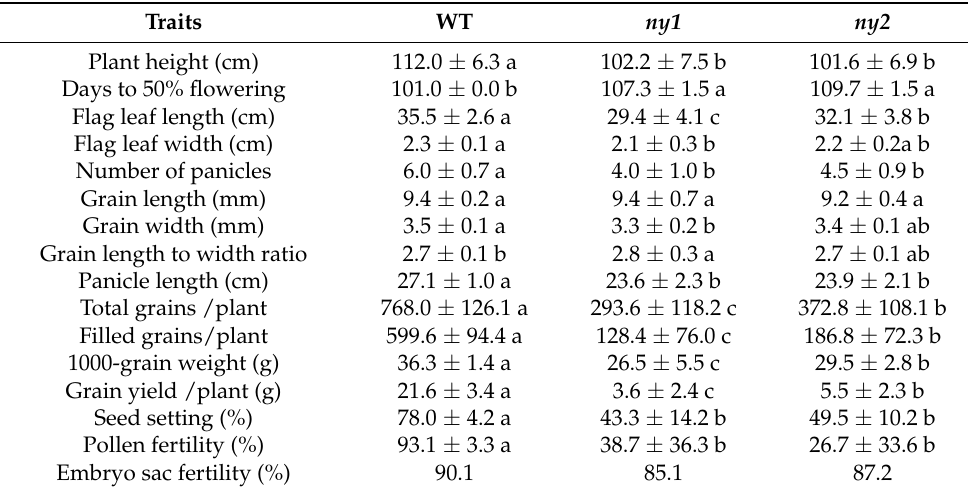
Table 2. Mean performance of agronomic traits, pollen fertility and embryo sac fertility of WT, ny1 and ny2 mutant lines.